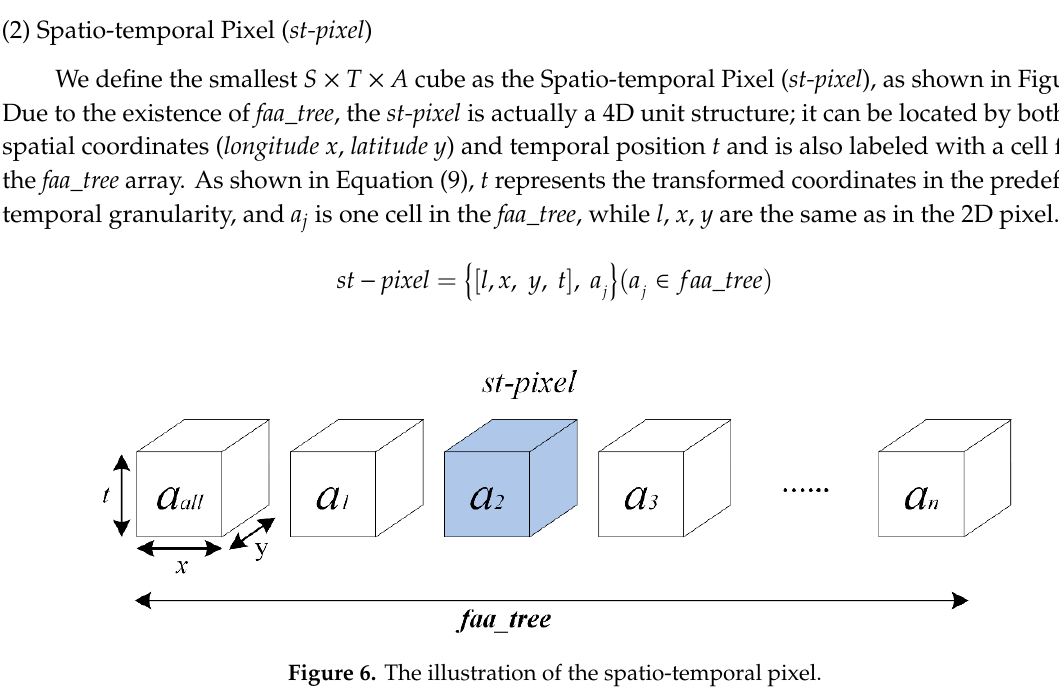
Figure 6. The illustration of the spatio-temporal pixel.